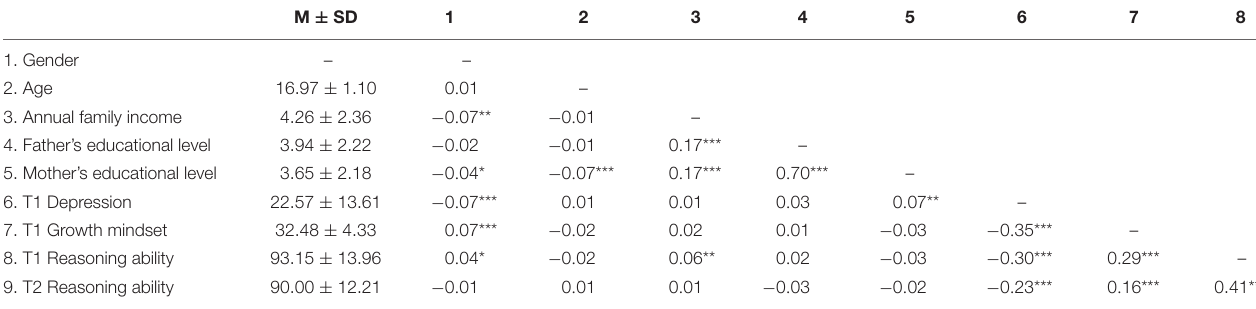
TABLE 2 | Demographic results and Pearson correlations between variables.